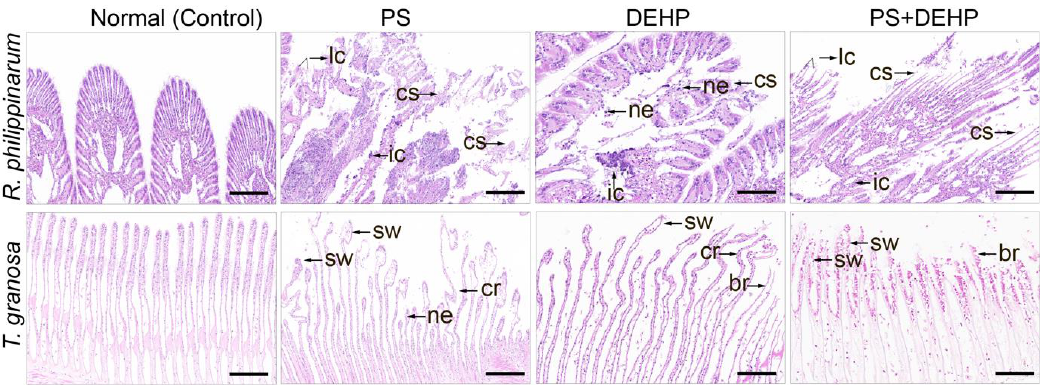
Figure 5. Representative images of haemotoxylin/eosin-stained sections of gill extracted from manila clams ( R. philippinarum ) and blood clams ( T. granosa ). Normal structure shown in the control group, histopathological changes occurred after single/co-exposure to polystyrene MPs/DEHP, Scale bar 200 μm. cs: ciliary structure destruction; lc: loss of contact between gill filaments; ic: inflammatory infiltration; ne: necrosis; cr: curly. sw: swollen; lh: rare in hemocytes; br: broken; ne: necrosis.